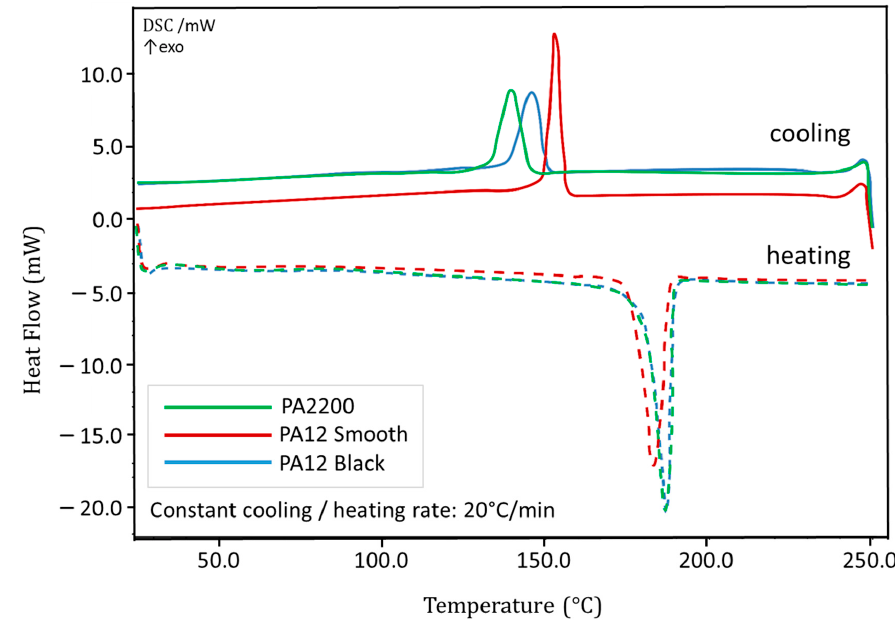
Figure 5. Di ff erential Scanning Calorimetry (DSC) thermograms of powders PA2200, PA12 Smooth Figure 5. Differential Scanning Calorimetry (DSC) thermograms of powders PA2200, PA12 Smooth and PA12 Black. and PA12 Black.